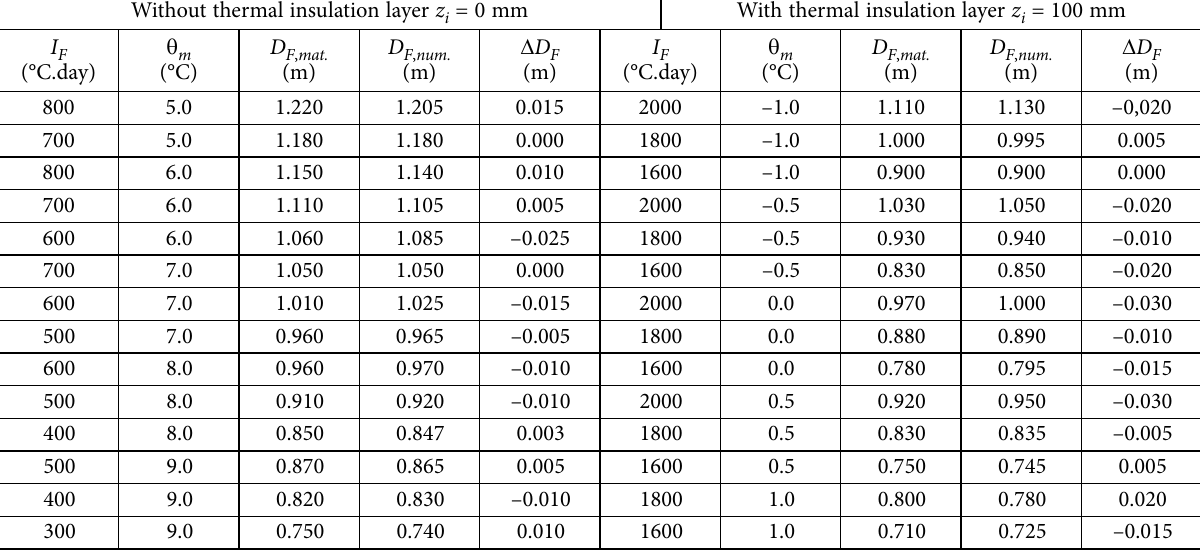
Table 7. Comparison of values of the depth of freezing of the railway track structure determined by mathematical D F , mat and numerical D F , num method depending on the air frost index I F and the average annual air temperature q m (the sub-ballast layers without and with a built-in thermal insulation layer of extruded